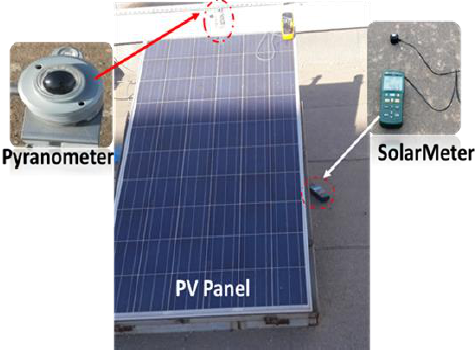
Figure 7. Experimental set-up of the measurement system.